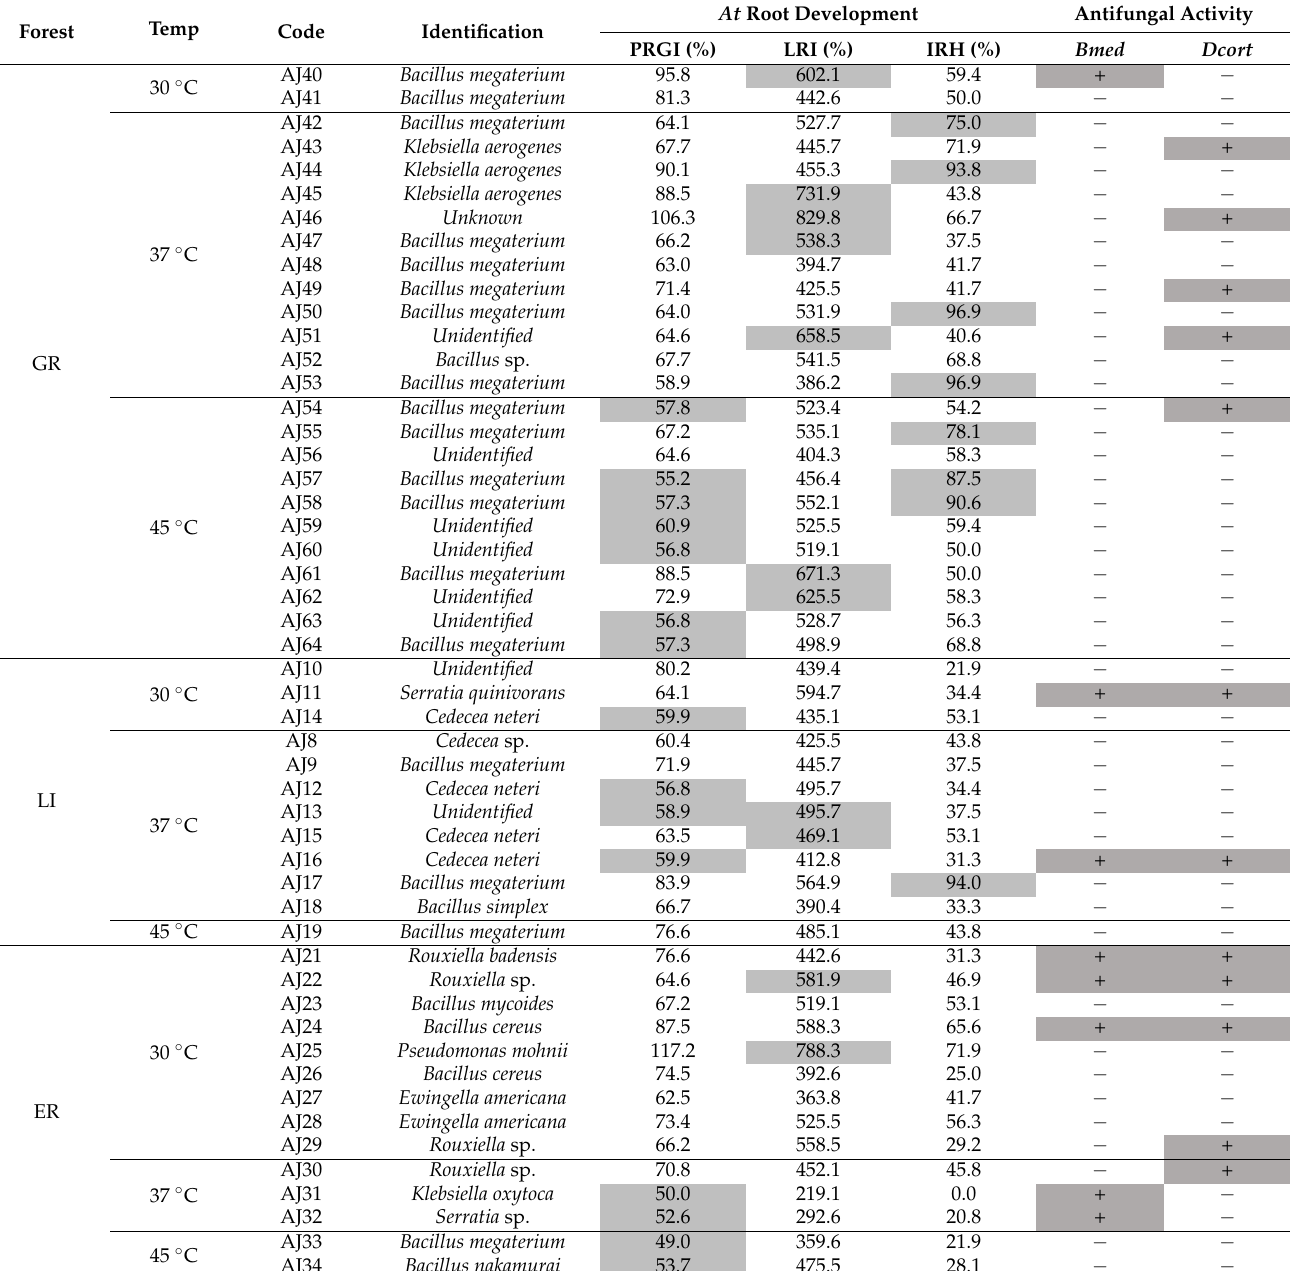
Table 1. Effects of selected PGPR on A. thaliana ( At ) root architecture and their antifungal activity against cork oak pathogens. Arabidopsis root development was evaluated considering the primary root growth induction (PRGI), lateral roots induction (LRI) and root hair presence (IRH). Displayed values represent data at 9 dpi and the most noticeable effects are highlighted in grey, as detailed in Tables S2–S4. Antifungal activity against B. mediterranea ( Bmed ) and D. corticola ( Dcort ) of selected PGPR, detected after five and three days, respectively, is also highlighted in grey. Isolates are discriminated according to their origin (cork oak forest) and temperature used for